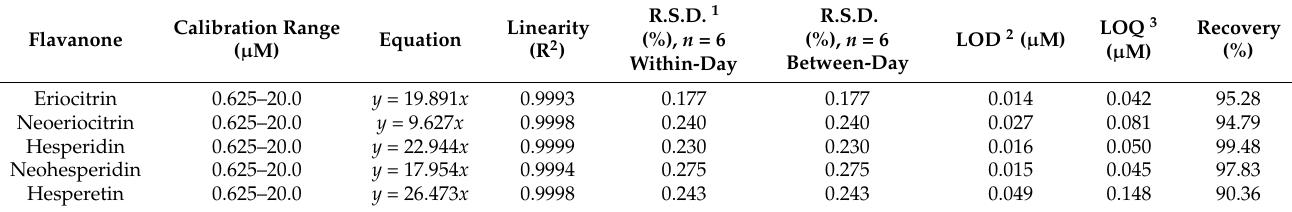
Table 1. Method validation